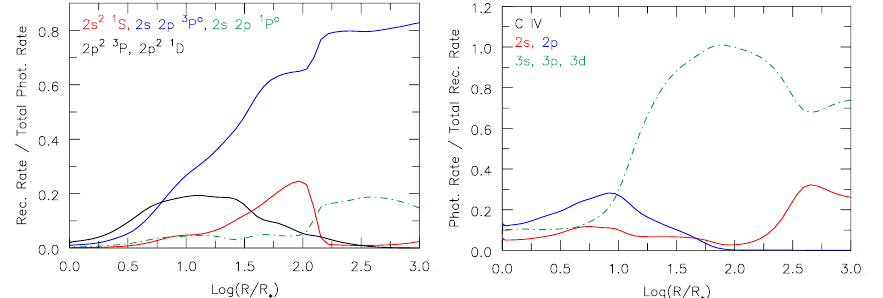
Figure 12. Illustration of the model photoionization rates for the WC4 star, BAT99-9. For illustration purposes, the rates for the 3 l states have been combined in the right plot.